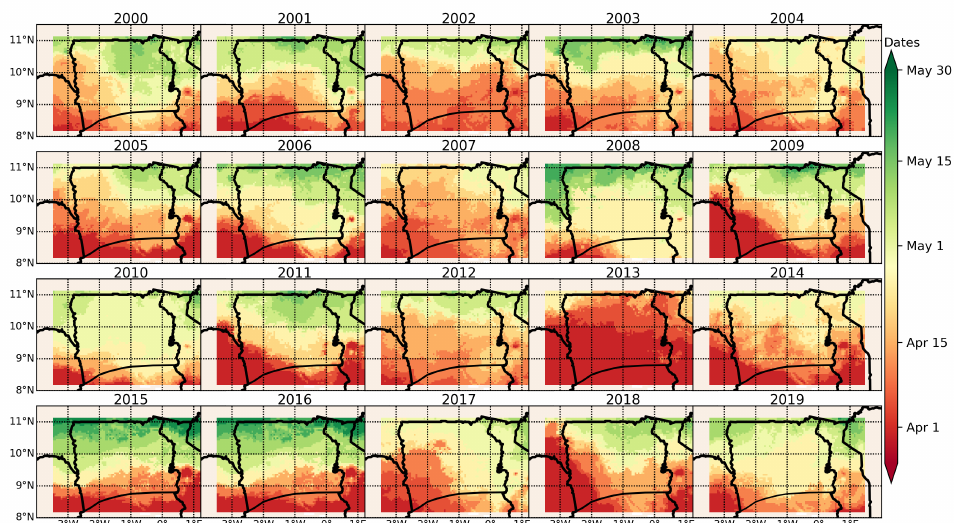
Figure 2. Variability of rainfall onsets dates from 2000 to 2019 over Northern Ghana generated from CHIRPS-v2 data.